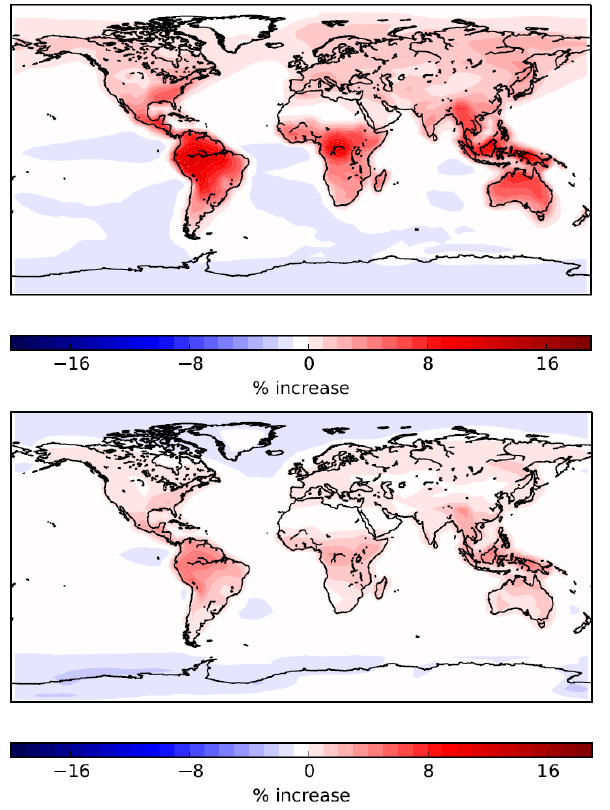
Figure 8. Percentage increase of surface OH concen- trations calculated from rate constant and yields from this study ( α (R5a) = 0 . 37, α (R5b) = 0 . 12, α (R5c) = 0 . 51, k (R5) = 2.4 × 10 − 11 cm 3 molecule − 1 s − 1 ) compared to (a) the same overall rate coefficient but with the OH channel set to zero ( α (R5a) = 0.75, α (R5b) = 0.25, α (R5c) = 0.) and with (b) the IUPAC recommendation ( α (R5a) = 0.41, α (R5b) = 0.15, α (R5c) = 0.44, k (R5) = 1.4 × 10 − 11 cm 3 molecule − 1 s − 1 ) .